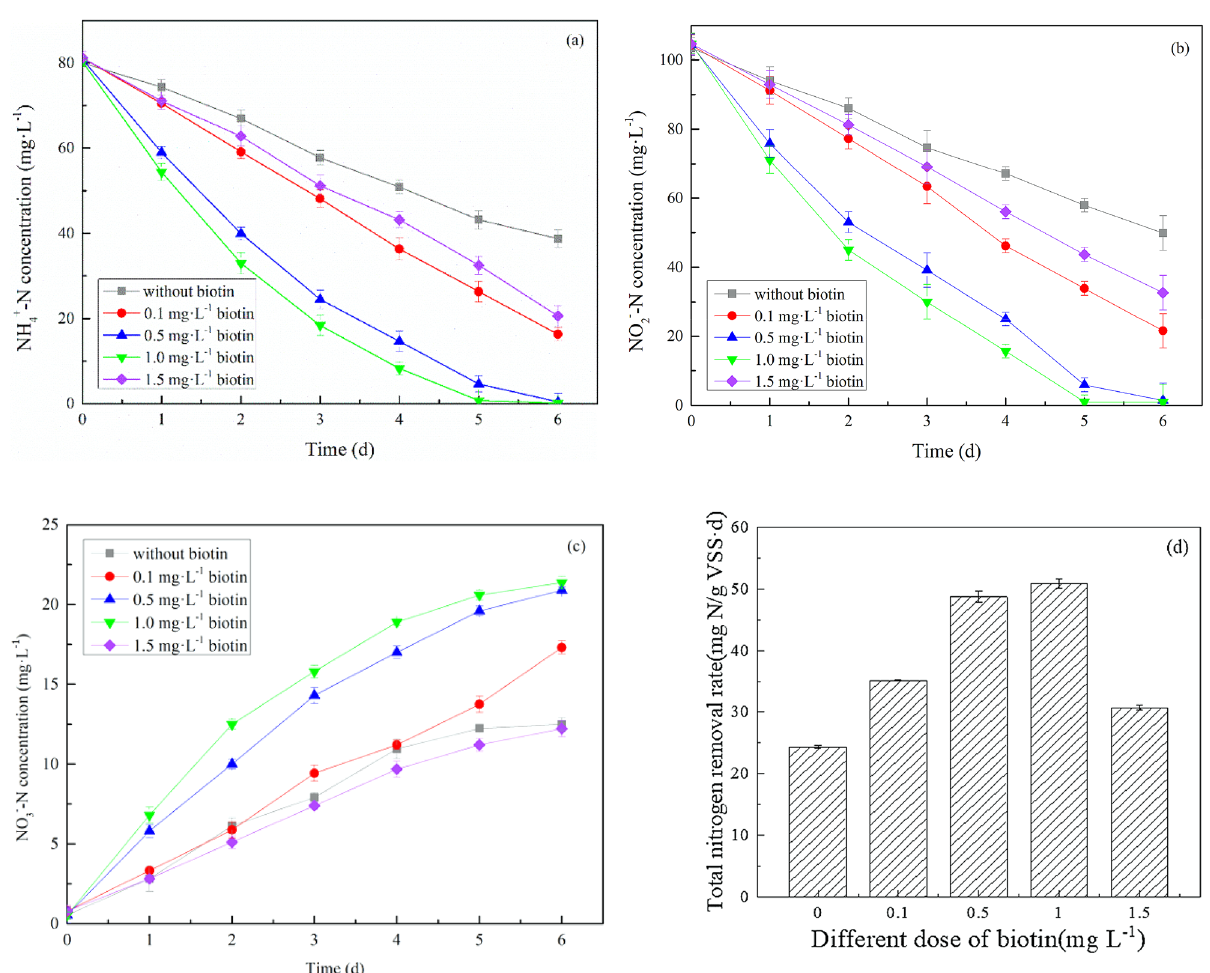
Figure 2. Concentrations of NH 4+ –N ( a ), NO 2− –N ( b ), and NO 3− –N ( c ) with time, and the total nitrogen removal rate at the end of the experiment ( d